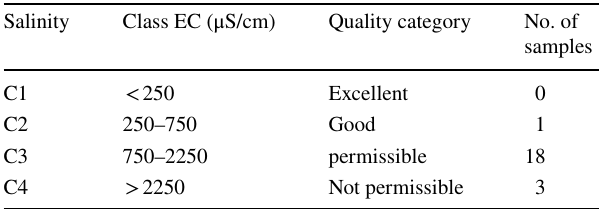
Table 6 Classification of irrigation water based on salinity (EC) (Richards 1954, Ntokozo Malaza 2017).